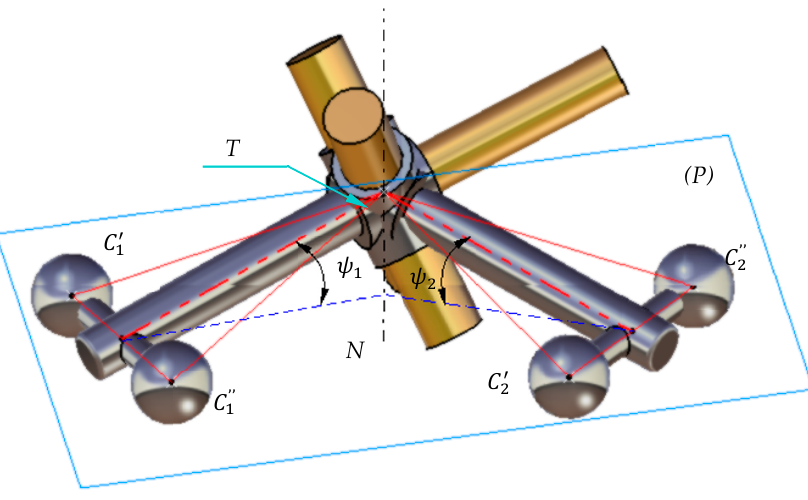
Figure 23. Identical oscillation angles of the intermediate element for the two assembling cases.